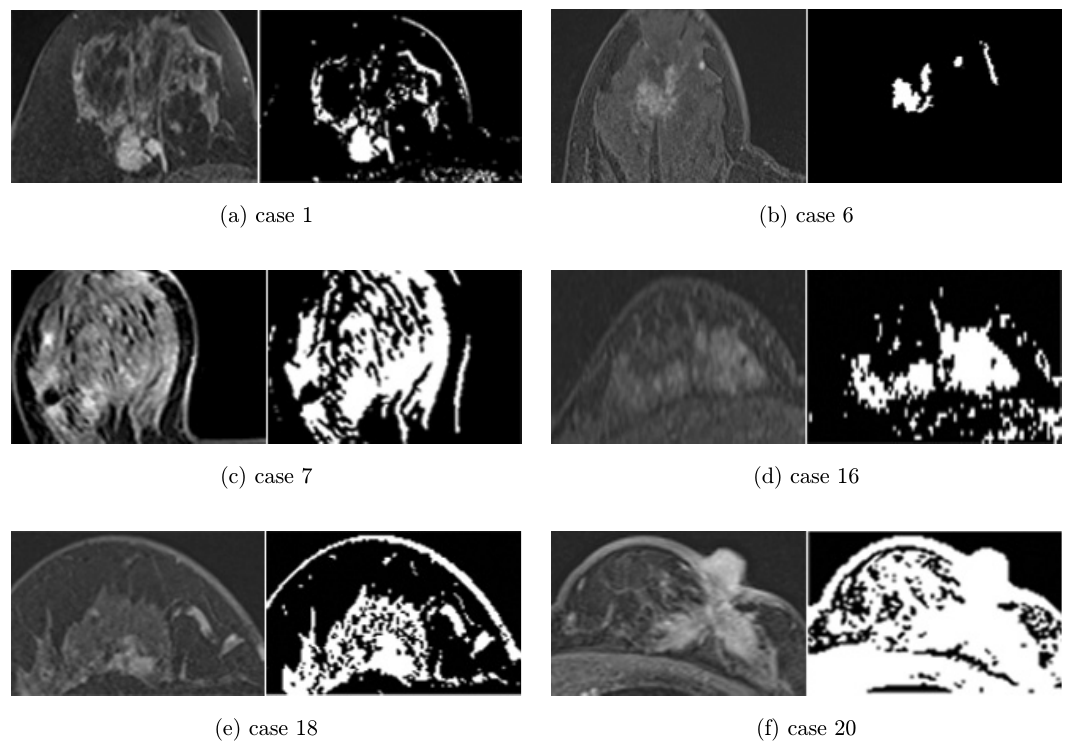
Fig. 2. Foreground of MRIs containing both mass (cases 1, 6 and 7) and nonmass (cases 16, 18 and 20) tumors, segmented based on Otsu's